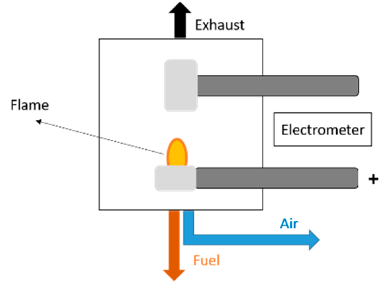
Figure 4. Flame ionization detector (FID)